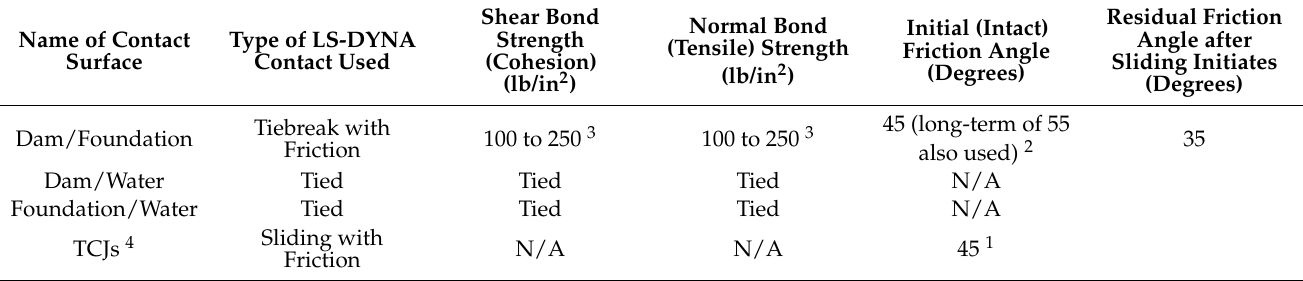
Table 7. Contact Surfaces used in the 3D Finite Element